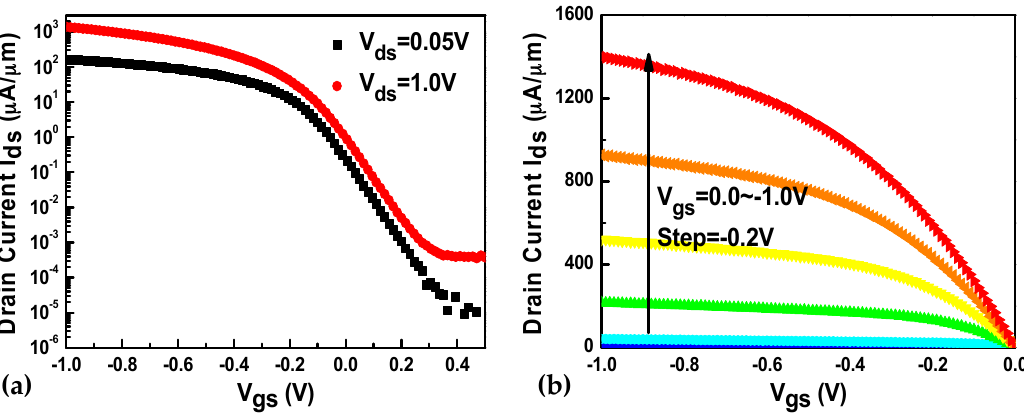
Figure 9. ( a ) Transfer characteristic; ( b ) output characteristic of P-type triangular GAA SNWT with D = 20 nm and L g = 140 nm.